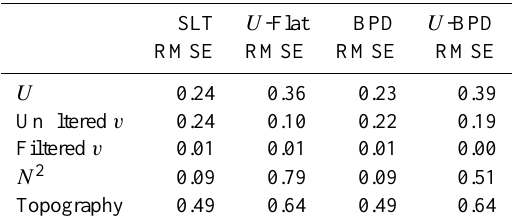
Table 4. Coefficient of Determination ( R 2 ) for each of the root mean square errors of the theoretical sections compared to the mean model section for different